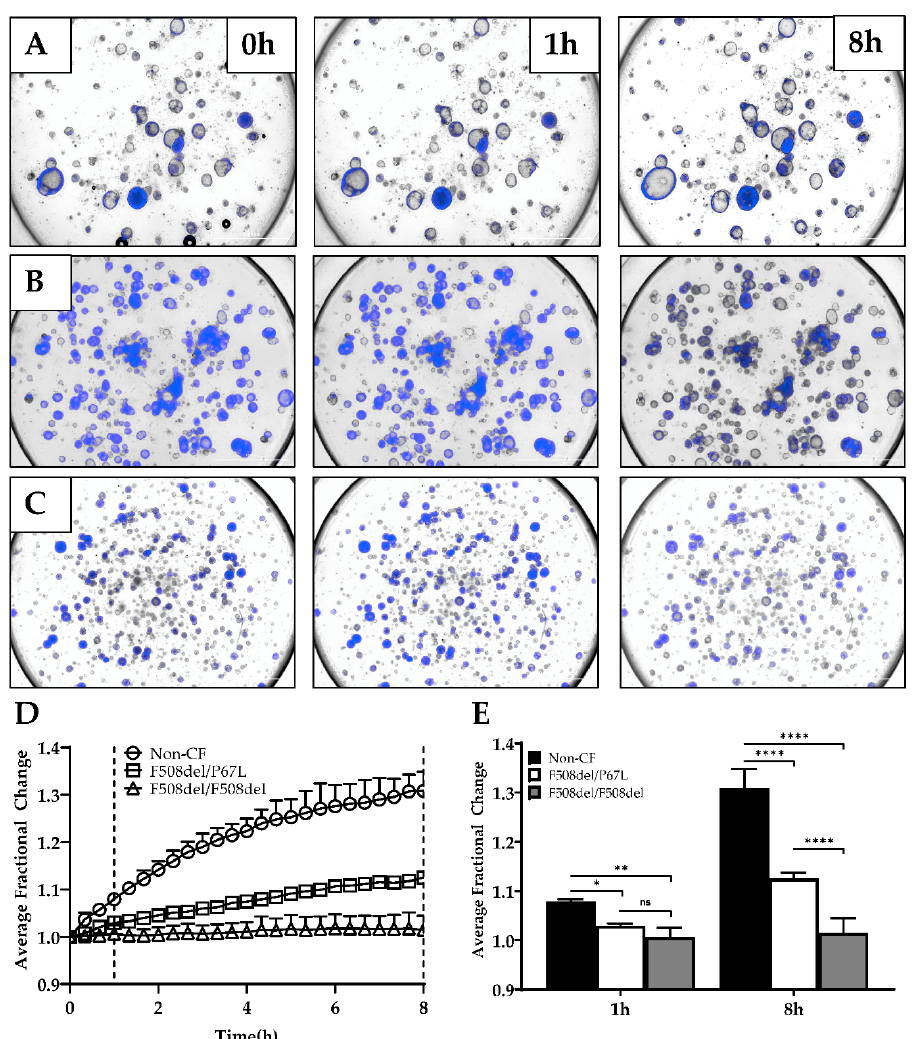
Figure 7. FIS assay. ( A–C ) Three representative brightfield and DAPI-stained images at times 0, 1, and 8 hours for non-CF ( A ), F508del/P67L ( B ), and F508del/F508del ( C ) CFTR HNE organoids. ( D ) Average fractional change from baseline over 8 h for each subject, dotted lines highlighting the 1- and 8-h timepoints. ( E ) 1-h vs. 8-h time points for the average fractional change of non-CF, F508del/P67L, and F508del/F508del organoids (n = 1). ( A ) Corresponds with Video S5 , ( B ) corresponds with Video S6 , and ( C ) corresponds with Video S7 . ns = not significant; * p = 0.0441, ** p = 0.0023, and **** p < 0.0001.